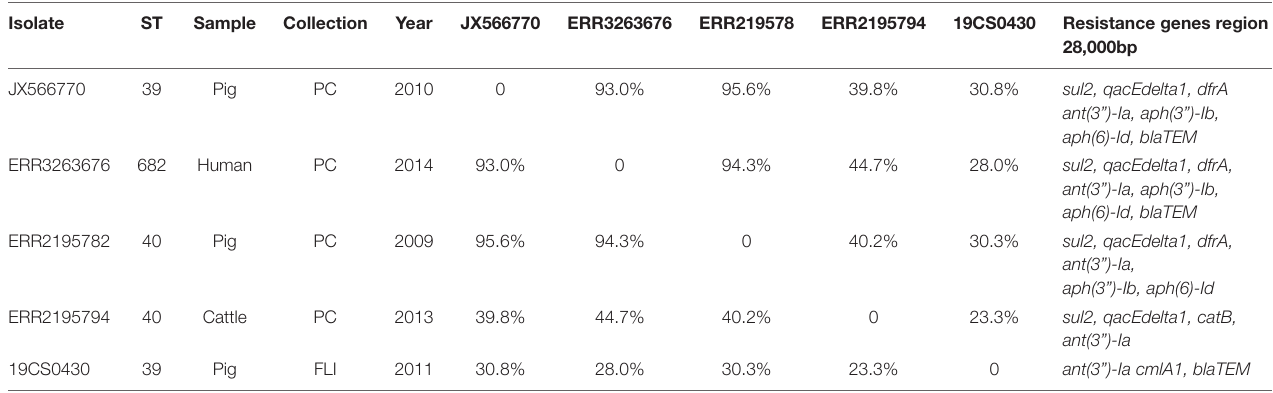
TABLE 5 | Percentage of identity between sequences with IncI1 ST26 CC-2 plasmid. Isolate ST Sample